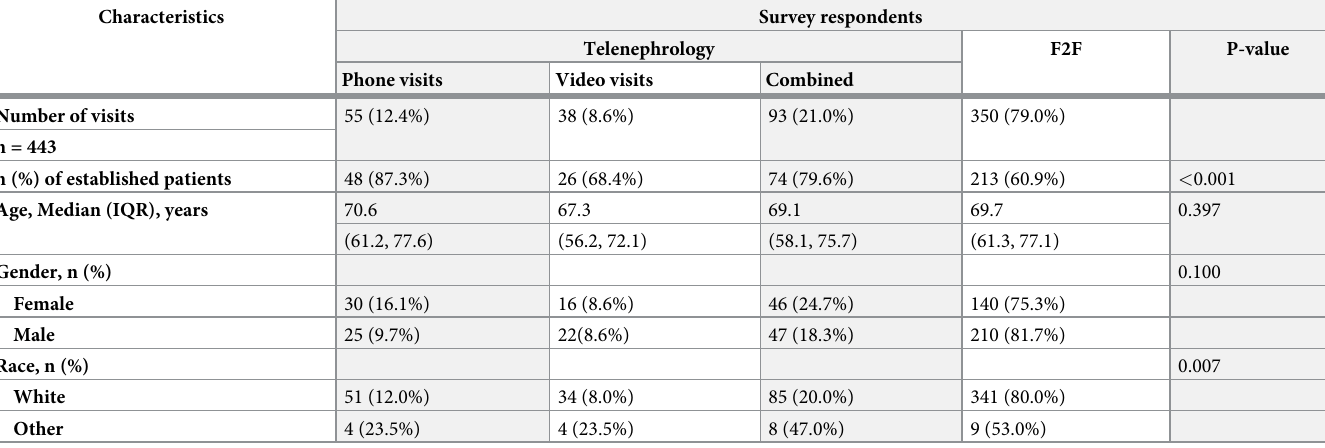
Table 2. Surveyed patients’ characteristics (March–July